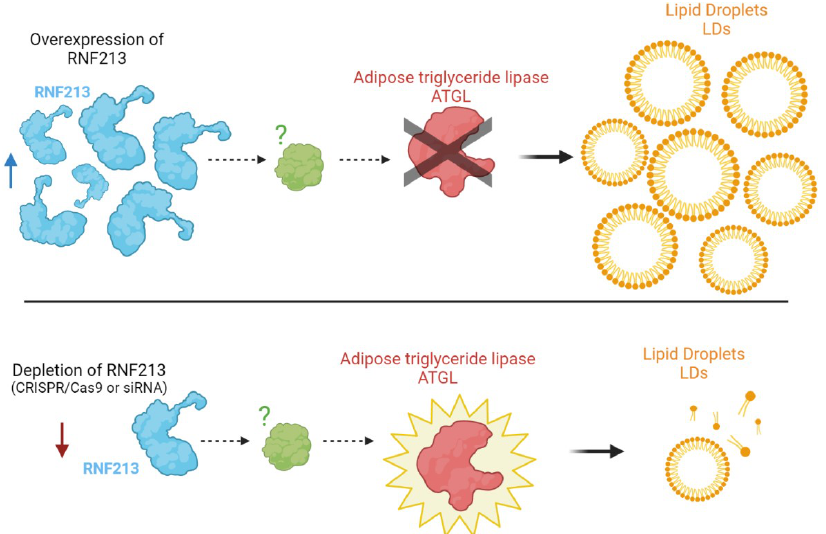
Figure 2. A possible link between RNF213 and lipid droplet (LD) stability. An overexpression of